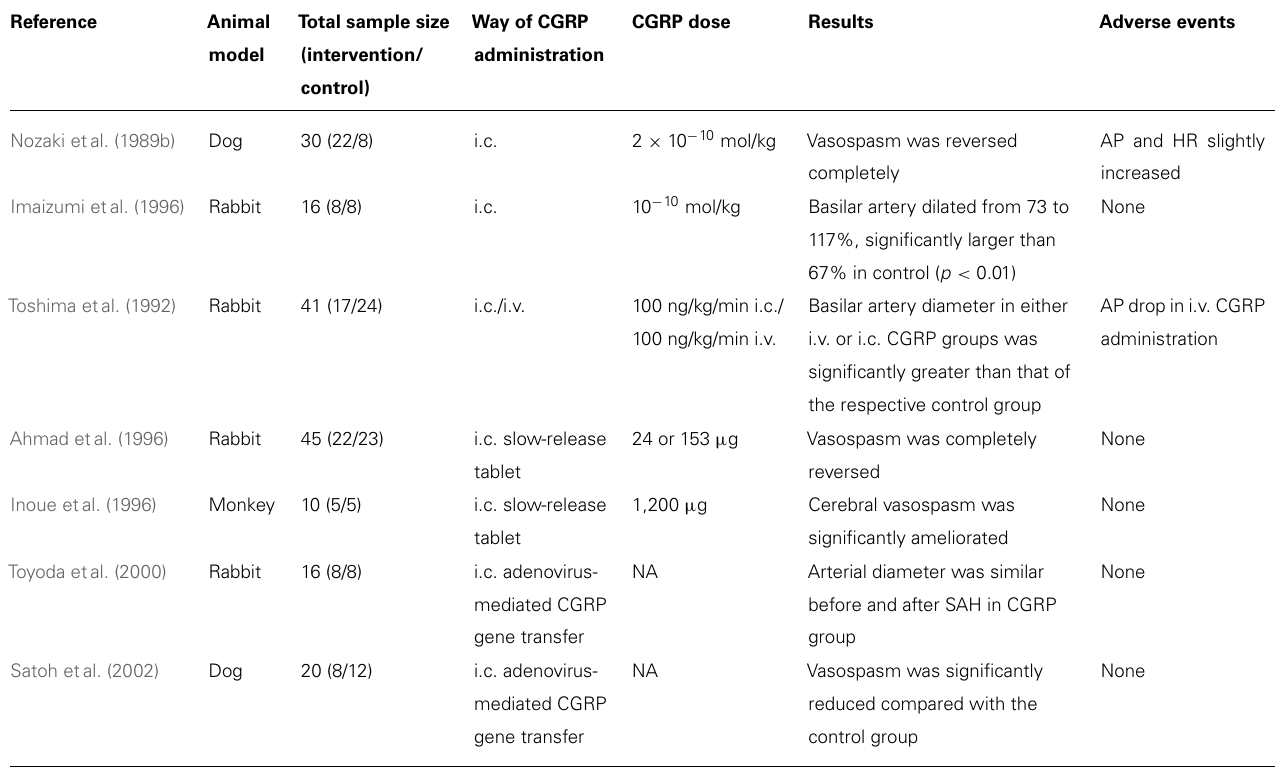
Table 1 | Studies of CGRP administration after experimental SAH in animals.